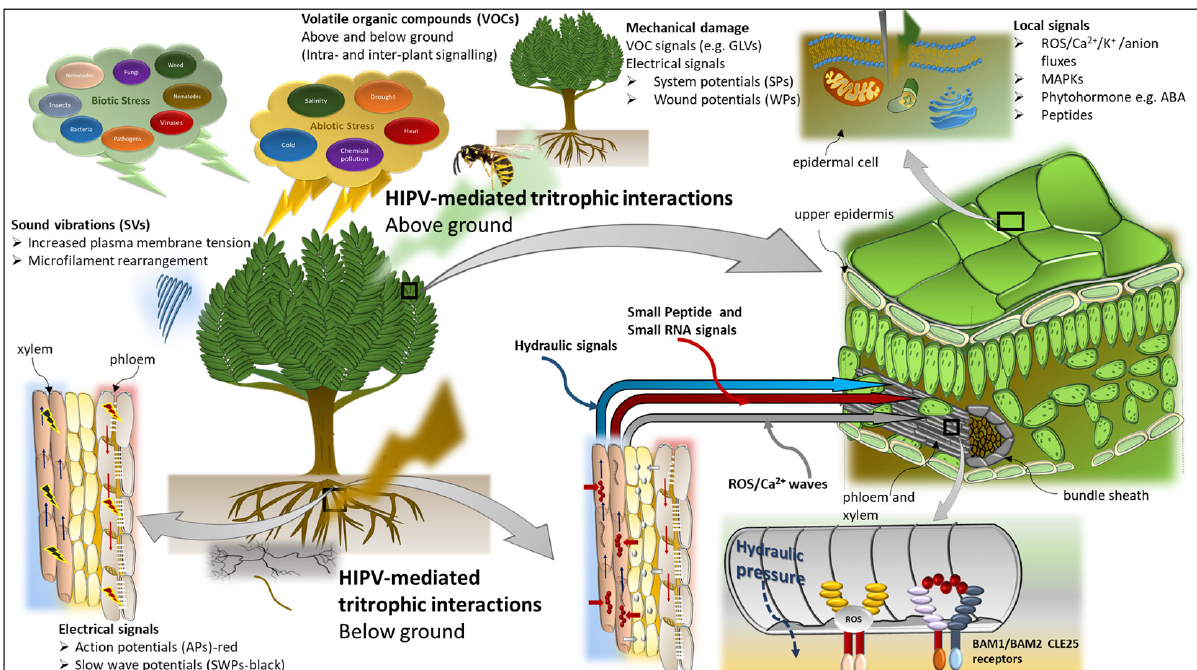
Figure 3. Overview of long distance signals in plants. Long-distance signals include electrical, hy- draulic, and chemical signals. Electrical signals found in plants include: slow wave potentials